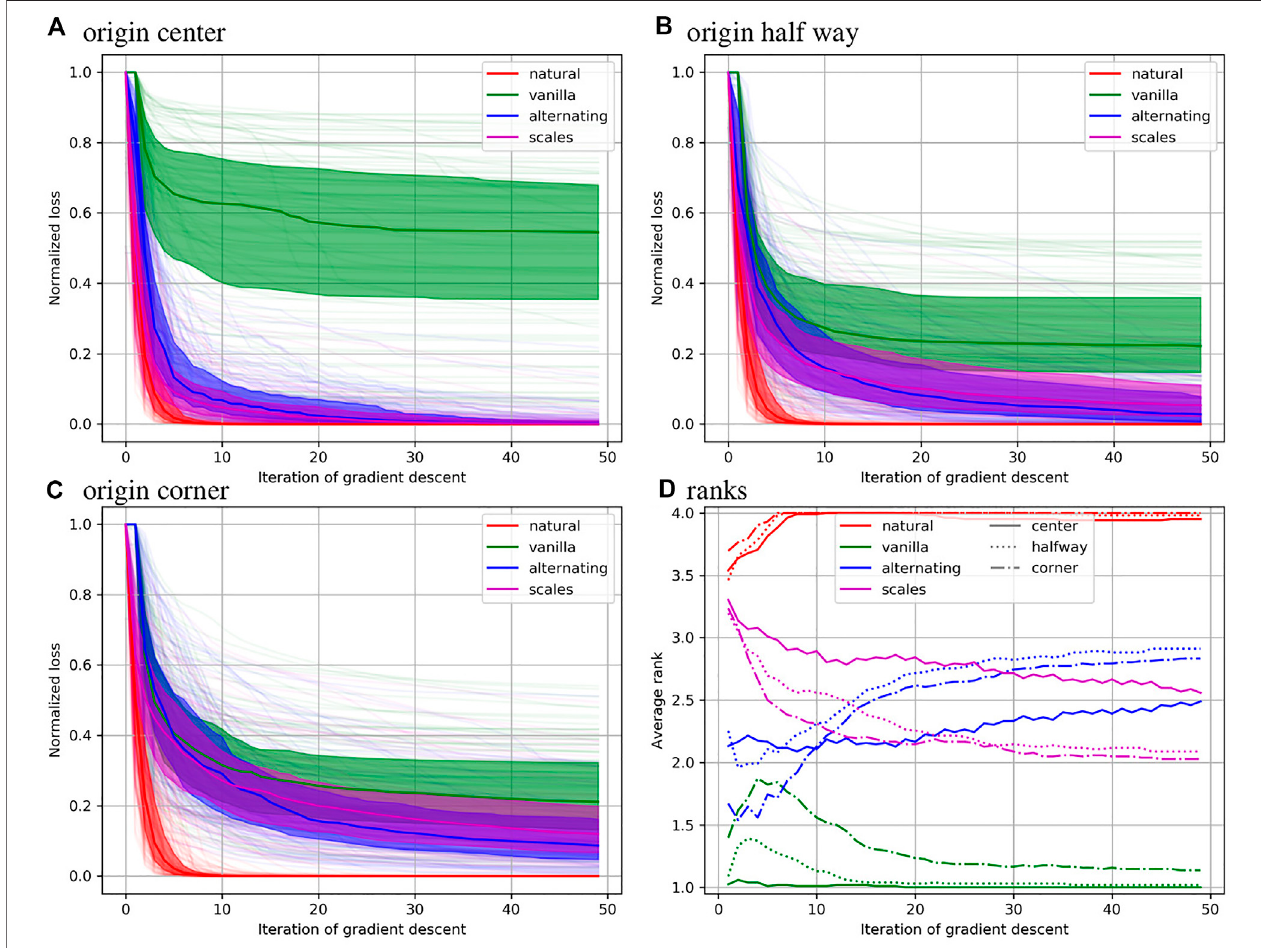
FIGURE5| Resultsofminimizingnegativemutualinformation12parameteraf fi neregistrationsareshownwiththecoordinateorigininthecenter (A) ,halfwaytothe corner (B) , and in the corner (C) . In these plots the normalized value of the objective function is shown at each iteration of gradient based optimization. In (D) the rank of each method is shown under each of these